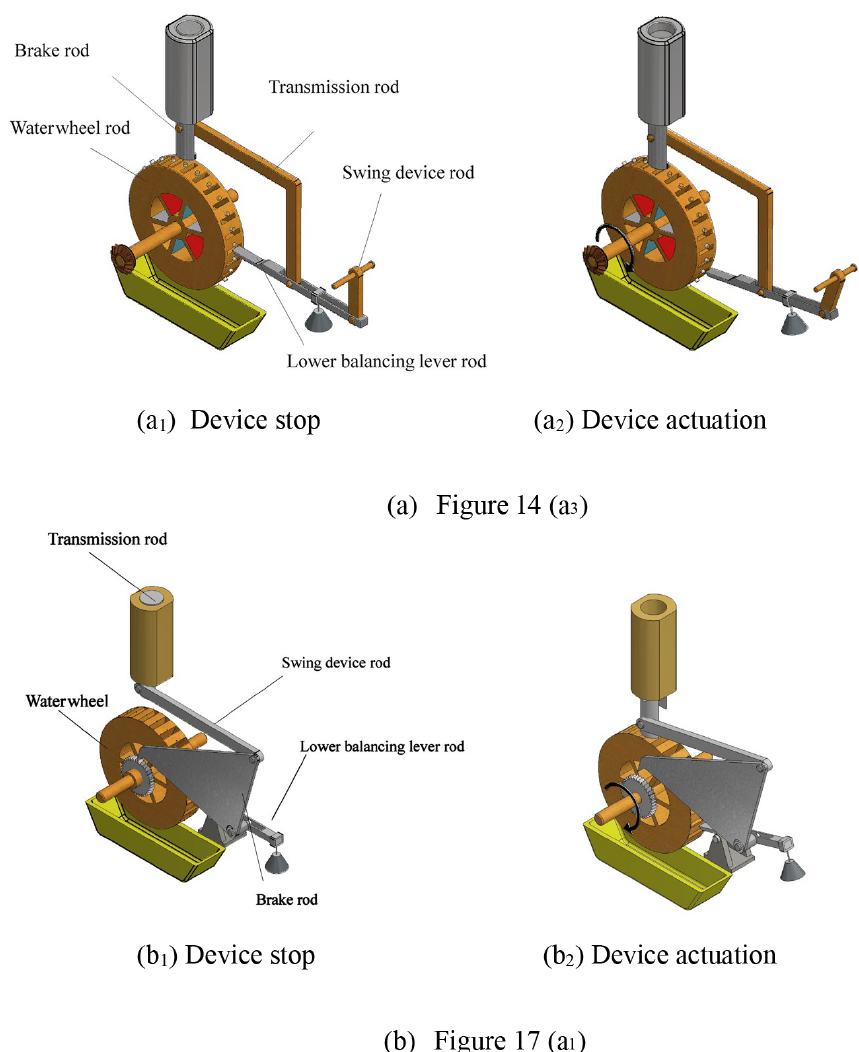
Figure 18. Actuation process of the waterwheel steelyard